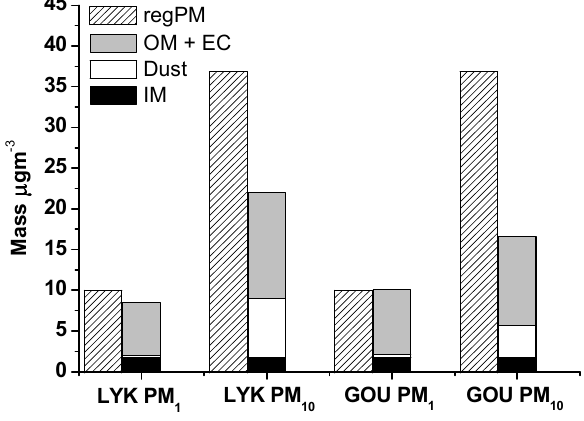
Fig. 11. Relative contribution of regional and local sources to PM levels in GAA. Regional PM (regPM) corresponds to PM measure- ments at